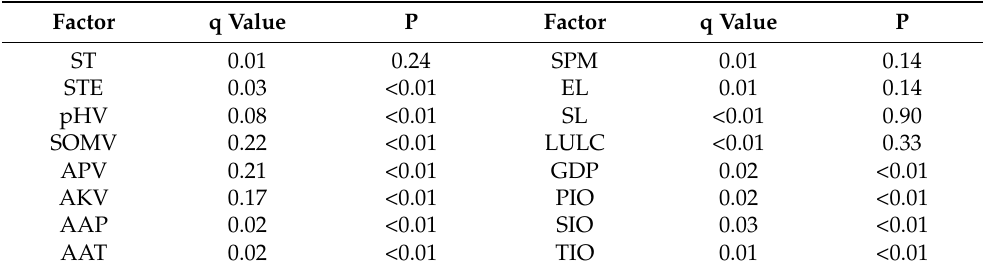
Table 3. The q-statistics of each factor related to the cultivated land quality variation. Factor q Value P Factor q Value P ST 0.01 0.24 STE